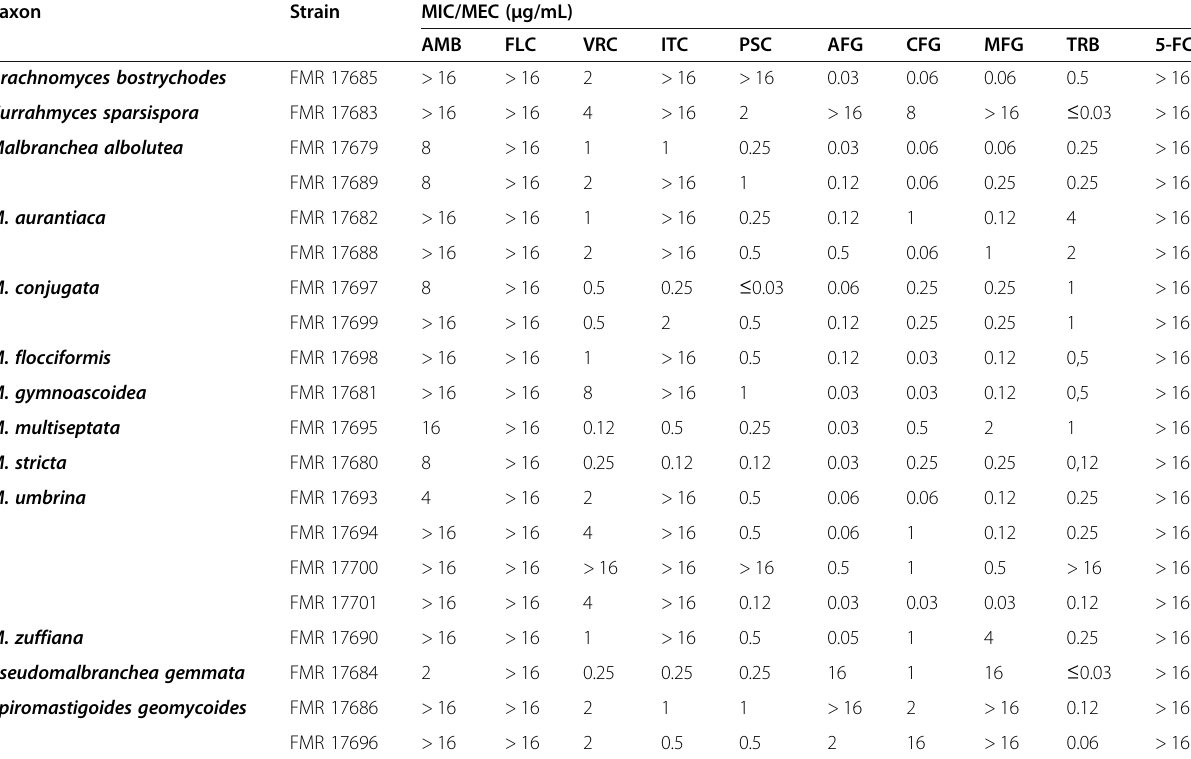
Table 2 Antifungal susceptibility of malbranchea - like strains studied